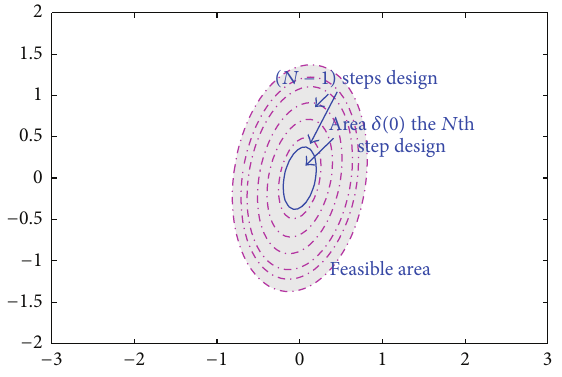
Figure 1: Simplified MPC schematic diagram.